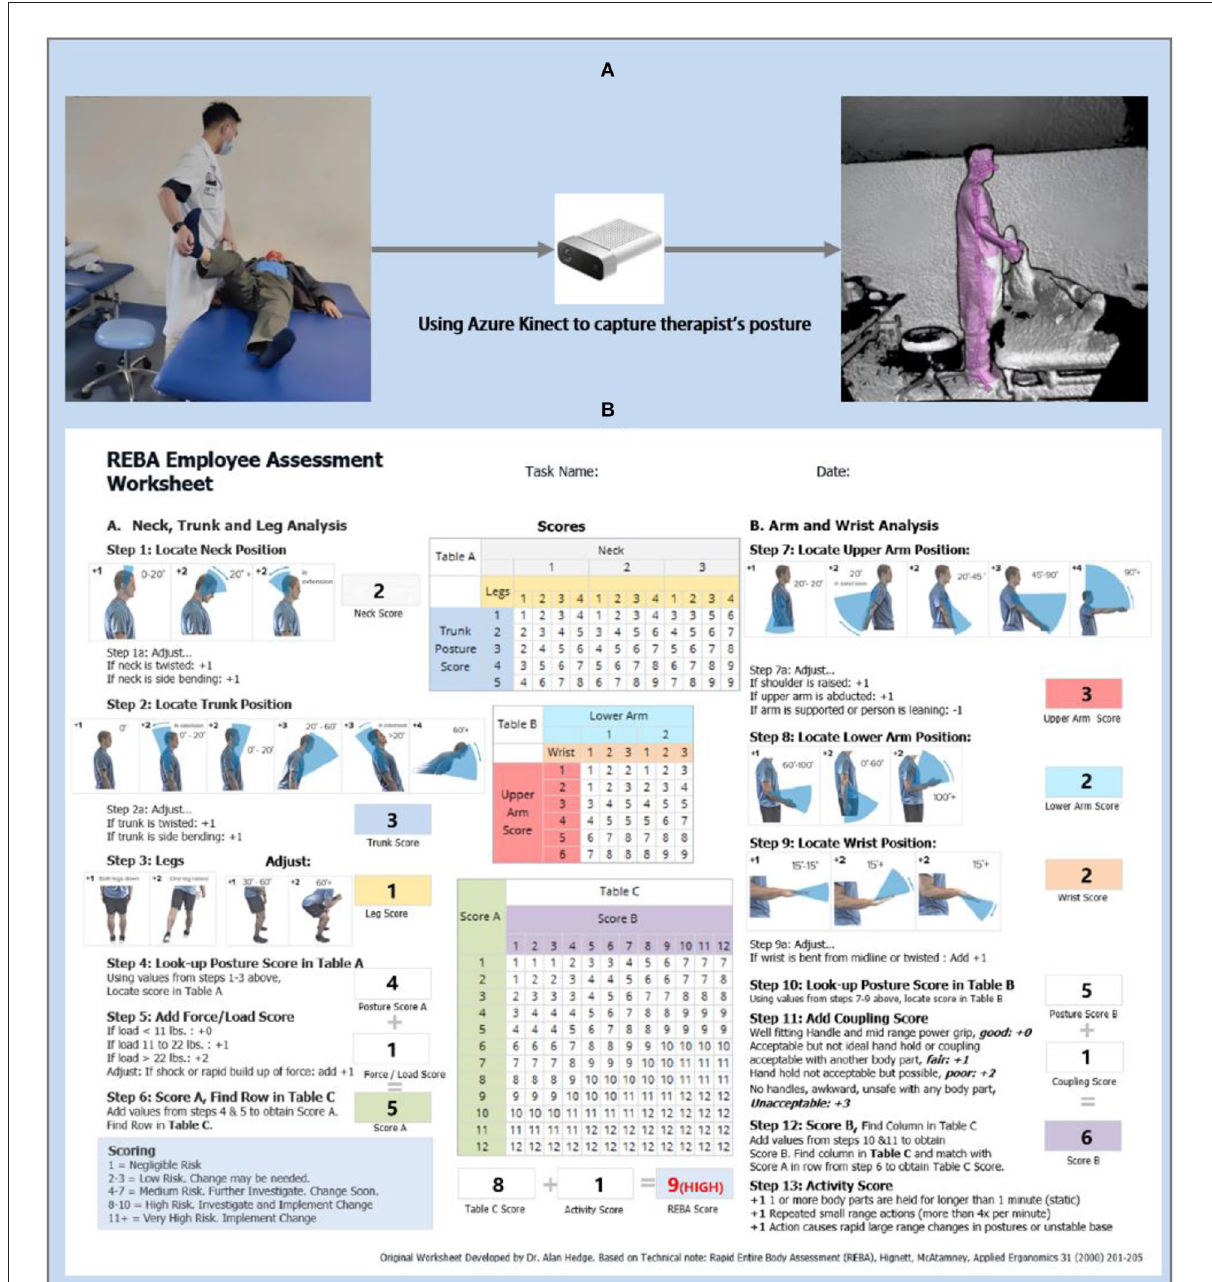
FIGURE1 (A) Capturing the therapist’s posture by Kinect. The leftmost of (A) represents the real environment in which physiotherapy is being performed. The middle is the sensor-Azure Kinect, and the rightmost is the modeling of the skeleton of the physiotherapist (B) . Example Rapid Entire Body Assessment (REBA) scoring for a